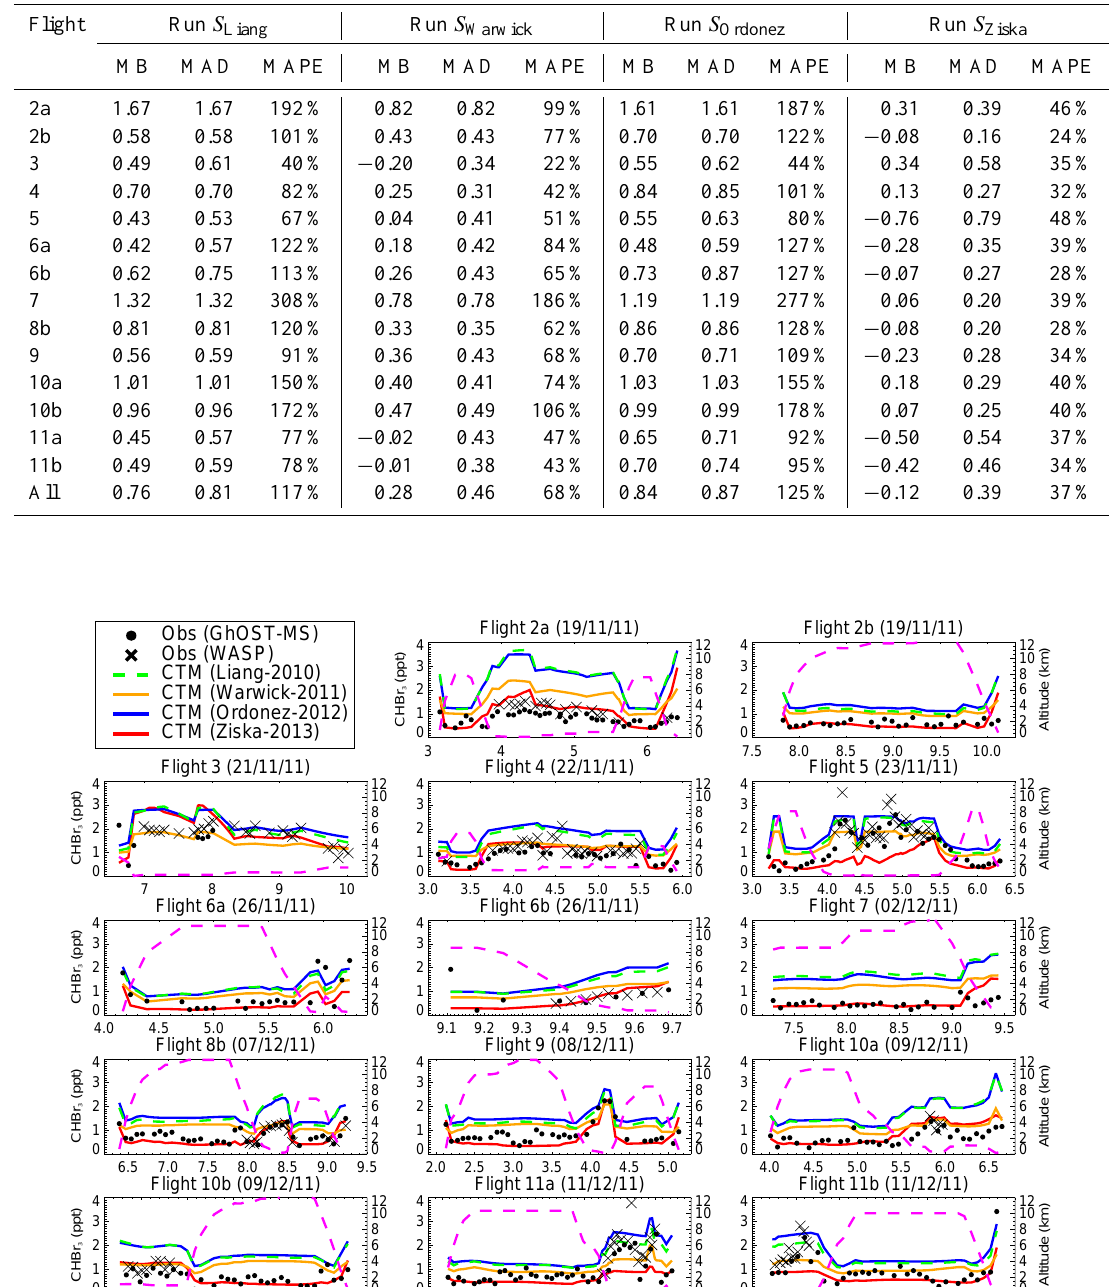
Table 7. Summary of calculated error metrics between CHBr 3 observed in the free troposphere during 14 flights of the SHIVA aircraft campaign (November–December 2011) with analogous fields from CTM runs S Liang , S Warwick , S Ordonez and S Ziska . Shown is the MB and the MAD both in units of ppt. Also shown is the MAPE (see text). These fields were calculated for all observations from both instruments deployed during SHIVA (i.e. GhOST-MS and WASP, see text). A mean value for all 14 flights is also reported.